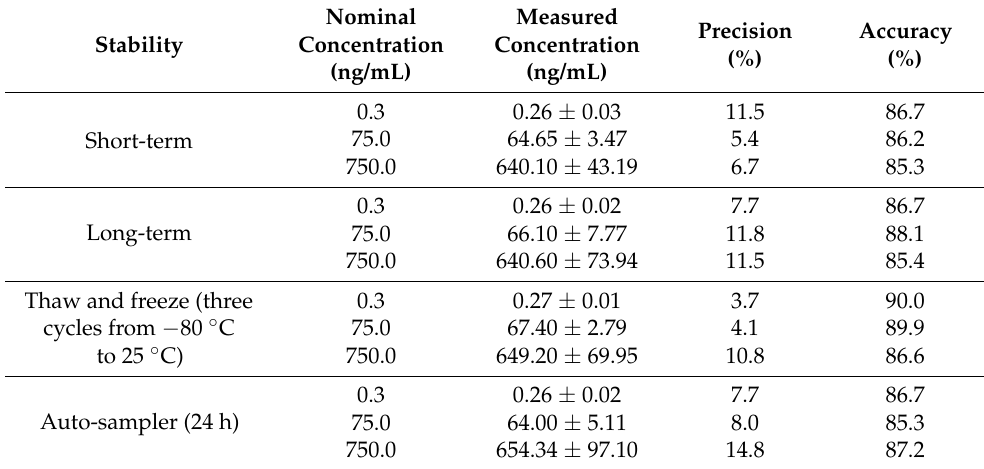
Table 4. Stability of Tamatinib in Rat Plasma under Different Storage and Processing